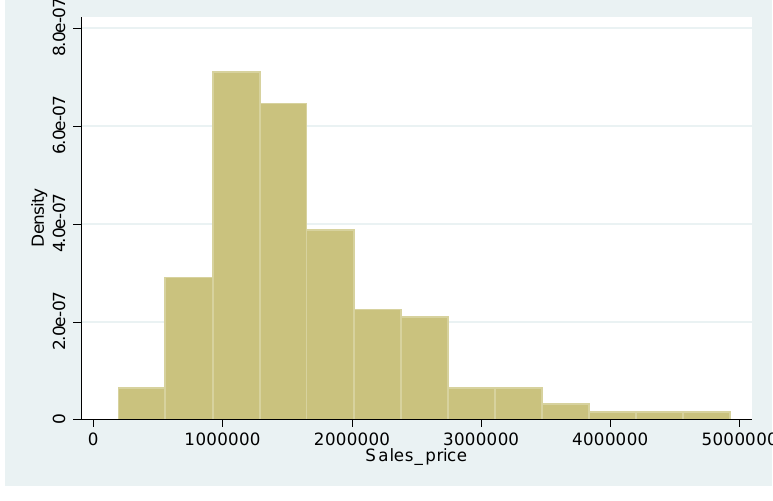
FIGURE 2: Actual sales price